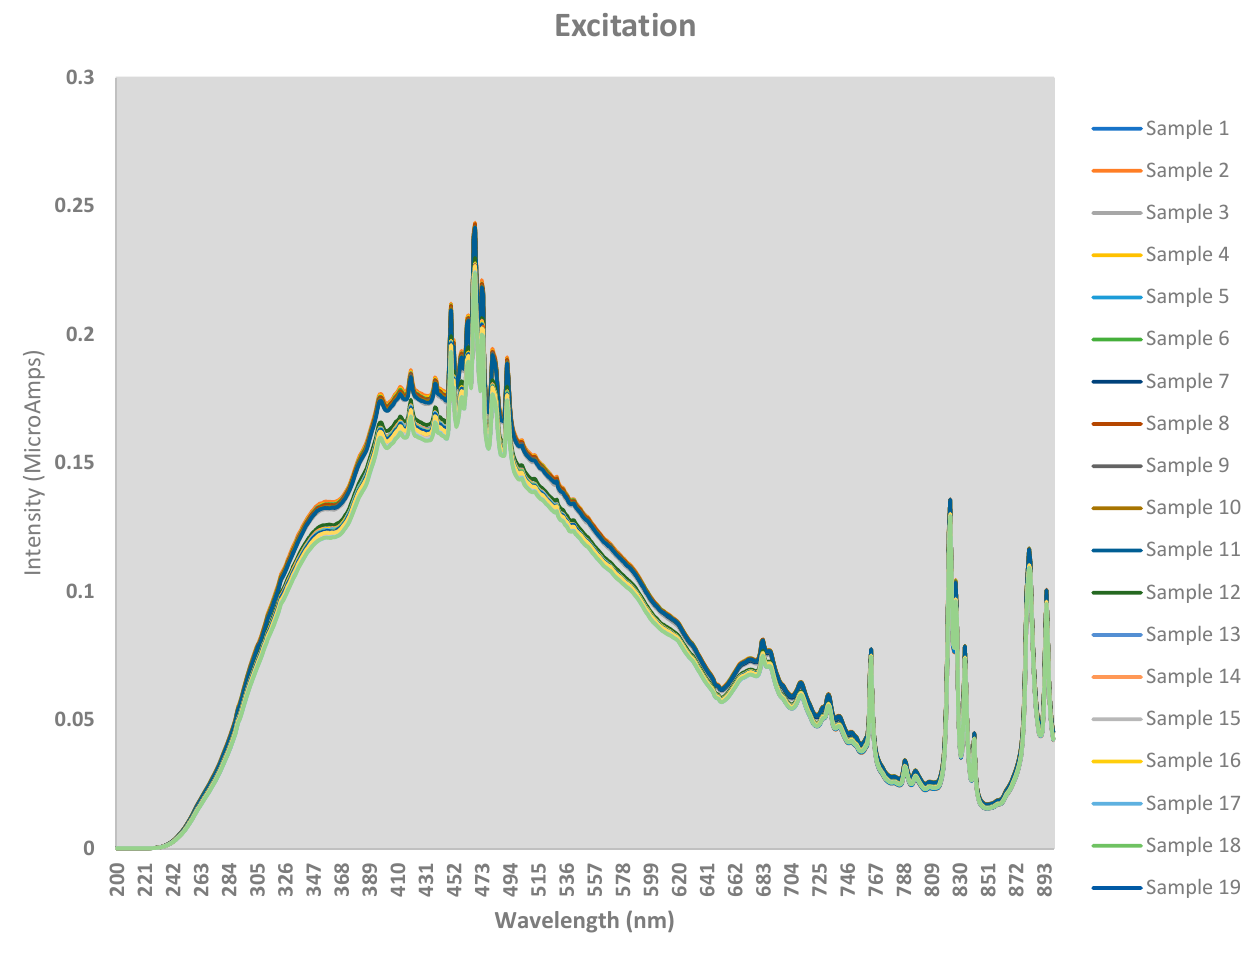
Figure 1. Excitation spectrums of all thirty baijiu samples.